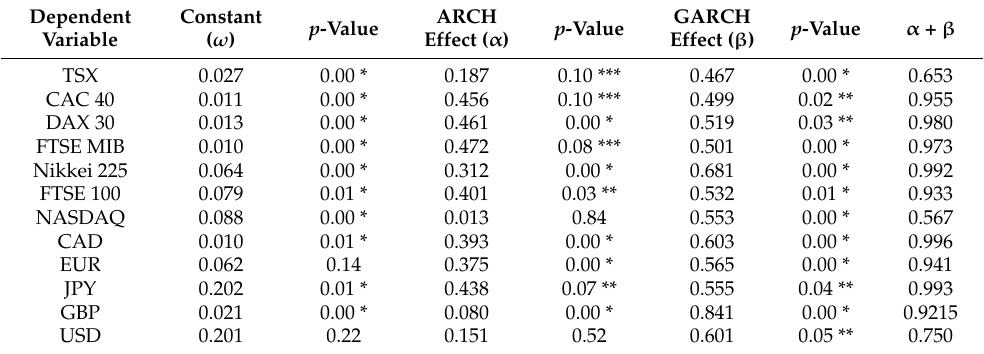
Table 4. FIGARCH test of Stock Market Indices, Currency Exchange Rates and Brent Crude Oil Prices. Dependent Constant ARCH GARCH p -Value p -Value p -Value α + Variable ( ω ) Effect ( α ) Effect ( β )